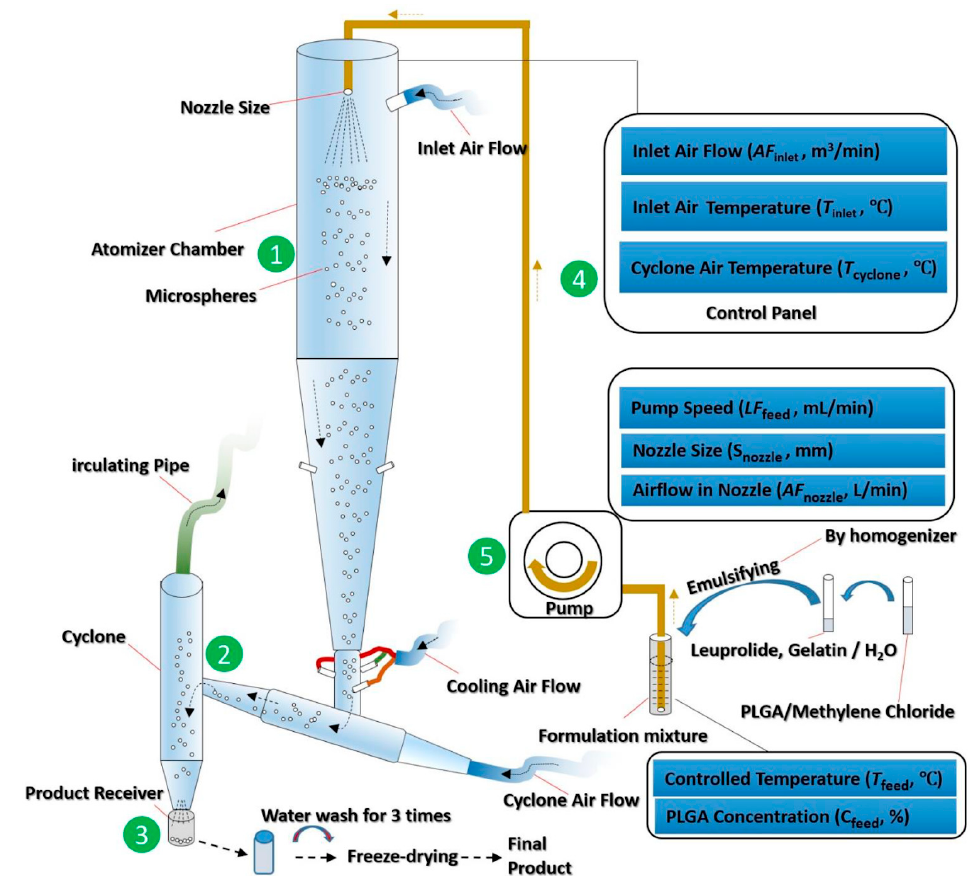
Figure 8. Schematic diagram of a spray drying process for manufacturing drug-loaded PLGA microspheres. Every aspect of the processing parameters, such as heat/mass transfer, inlet air temperature, and drying gas flow rate, requires optimisation in order to achieve the desired final products. (Reprinted from Journal of Controlled Release , 321, Nian-Qiu Shi, Jia Zhou, Jennifer Walker, Li Li, Justin K. Y. Hong, Karl F. Olsen, Jie Tang, Rose Ackermann, Yan Wang, Bin Qin, Anna P. Schwendeman, Steven P. Schwendeman, Microencapsulation of luteinizing hormone-releasing hormone agonist in poly (lactic- co -glycolic acid) microspheres by spray-drying, 756–772. Copyright (2020) with permission from Elsevier [88]).